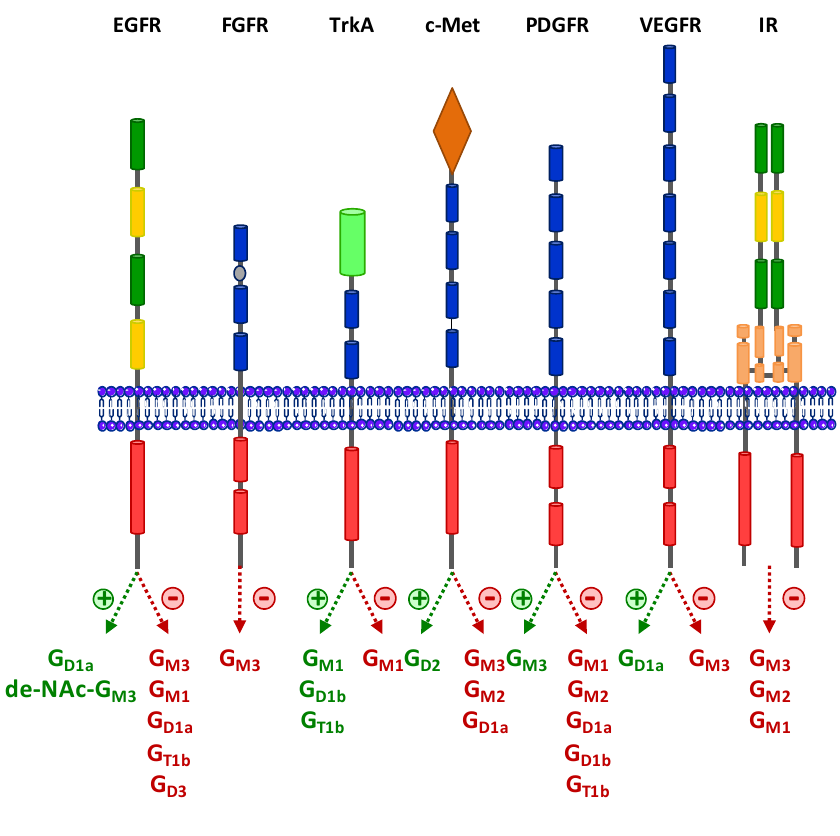
Figure 2. Regulation of RTKs activation by gangliosides. RTKs common structure consists in an extracellular domain containing the ligand binding site, a unique transmembrane domain and a cytoplasmic region containing the tyrosine kinase activity (in red). RTKs are activated by the binding of the ligand that induces receptor dimerization and the autophosphorylation of the intracellular domain. Gangliosides can either inhibit (red arrows) or activate (green arrows) of RTKs signaling, depending on gangliosides expression pattern, cell type, and experimental conditions. Three different mechanisms can be involved: ganglioside/ligand interactions, such as FGF/G interaction, the regulation of M1 with EGFR, or the regulation of RTKs activity due to the receptor demerization as for G M3 localization inside GEMs as the case for G with Insulin receptor (IR). Adapted and M3 updated from